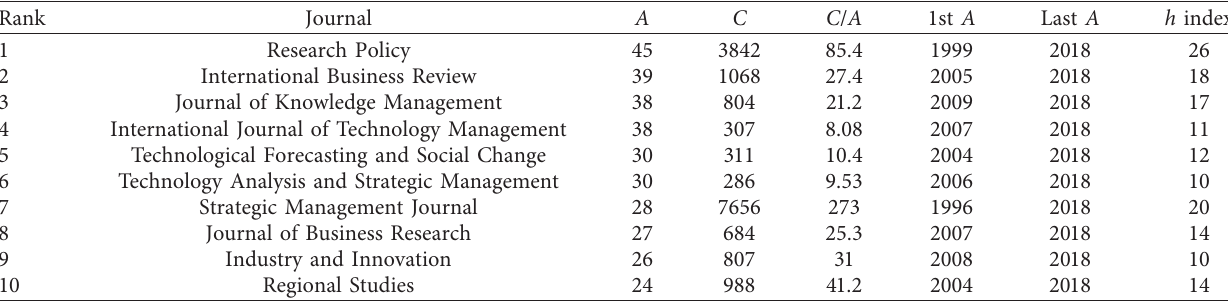
Table 3: Top ten most productive journals.